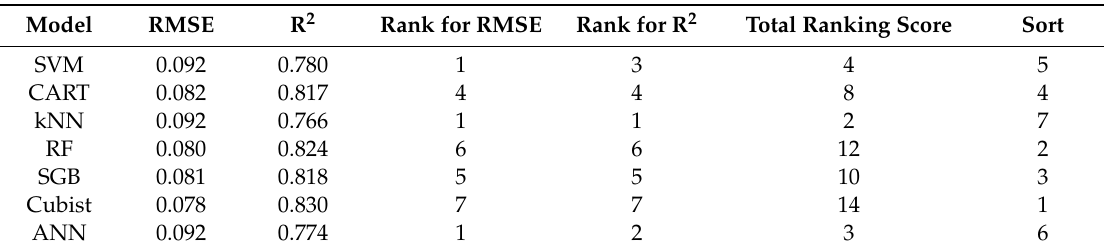
Table 4. Performance of the soft computing techniques for estimating ilmenite content (testing dataset).